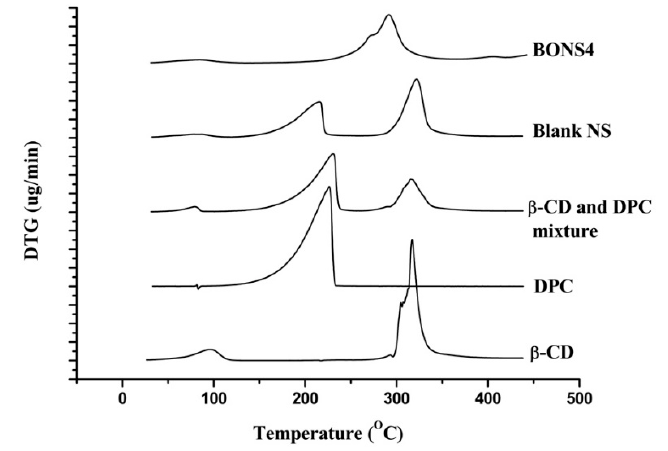
Figure 6. DTG curves of β -CD, DPC, β -CD and DPC mixture, blank NS, and BONS4. Table 4. Differential thermal analysis of the fabricating materials and nanosponges.